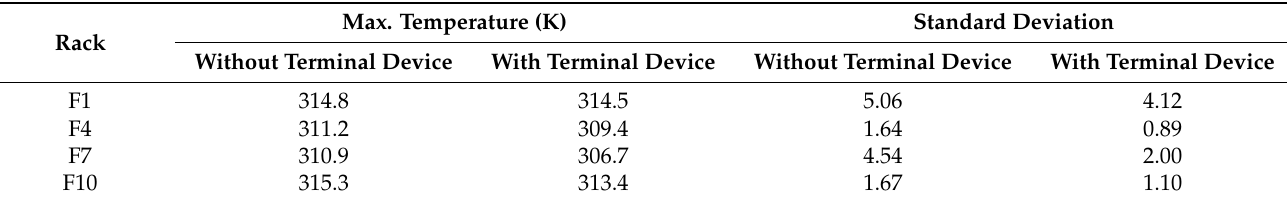
Figure 15. The exhaust air temperature distribution: ( a ) without terminal device; ( b ) with terminal device. Table 2. Max. temperature and standard deviation variation.